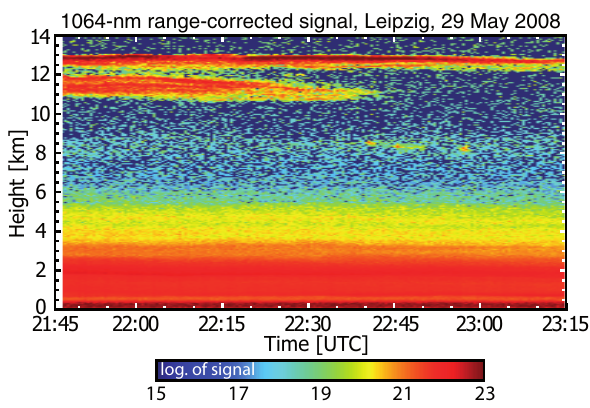
Fig. 3. Mean particle optical parameters (left: backscatter coef- ficient, center: extinction coefficient) for three laser wavelengths, backscatter coefficient for the cross–polarized 532 nm lidar channel (left, 532c nm, dark green), and particle volume concentration pro- files (right) for fine–mode and coarse–mode fractions retrieved with the LIRIC method based on the lidar observations on 29 May 2008 shown in Figure 2. The vertical resolution is 15 m. The reference height is set to z N = 9 km and the minimum measurement height is z N 0 = 150 m. The error bars show the uncertainties (standard deviation) of the LIRIC results (see discussion in section 3.1).